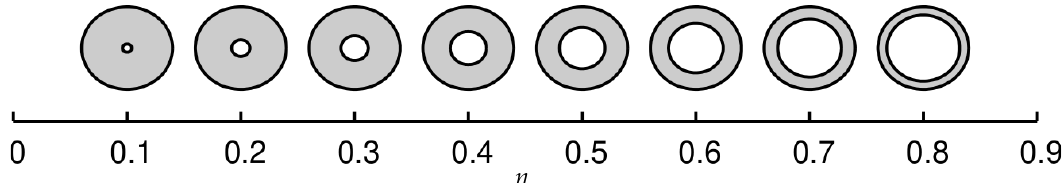
Figure 1. Illustration of shell thickness aspect ratio